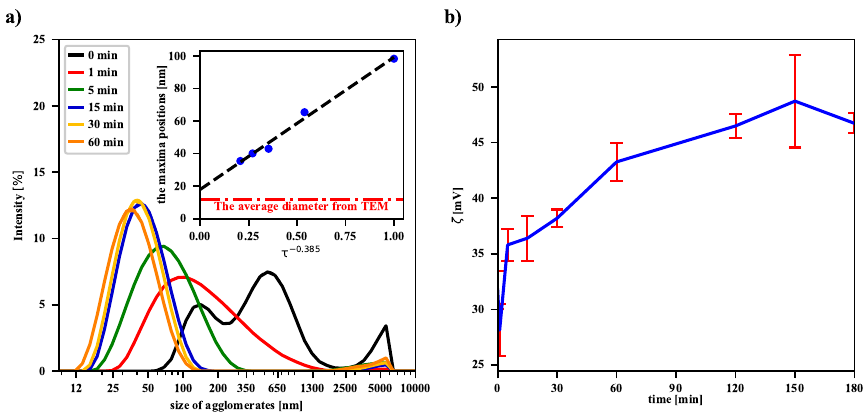
Figure 3. ( a ) The intensity-based size distribution of the nanoparticle agglomerates dispersed in an aqueous suspension with pH = 11.5 for different sonication durations. The inset suggests the power-law dependence of the mean HD on the duration of the sonication process, where the HD offset is 17.6 nm. The dimensionless quantity τ is defined as (the sonication time)/(1 min). ( b ) The dependence of the zeta potential on the sonication